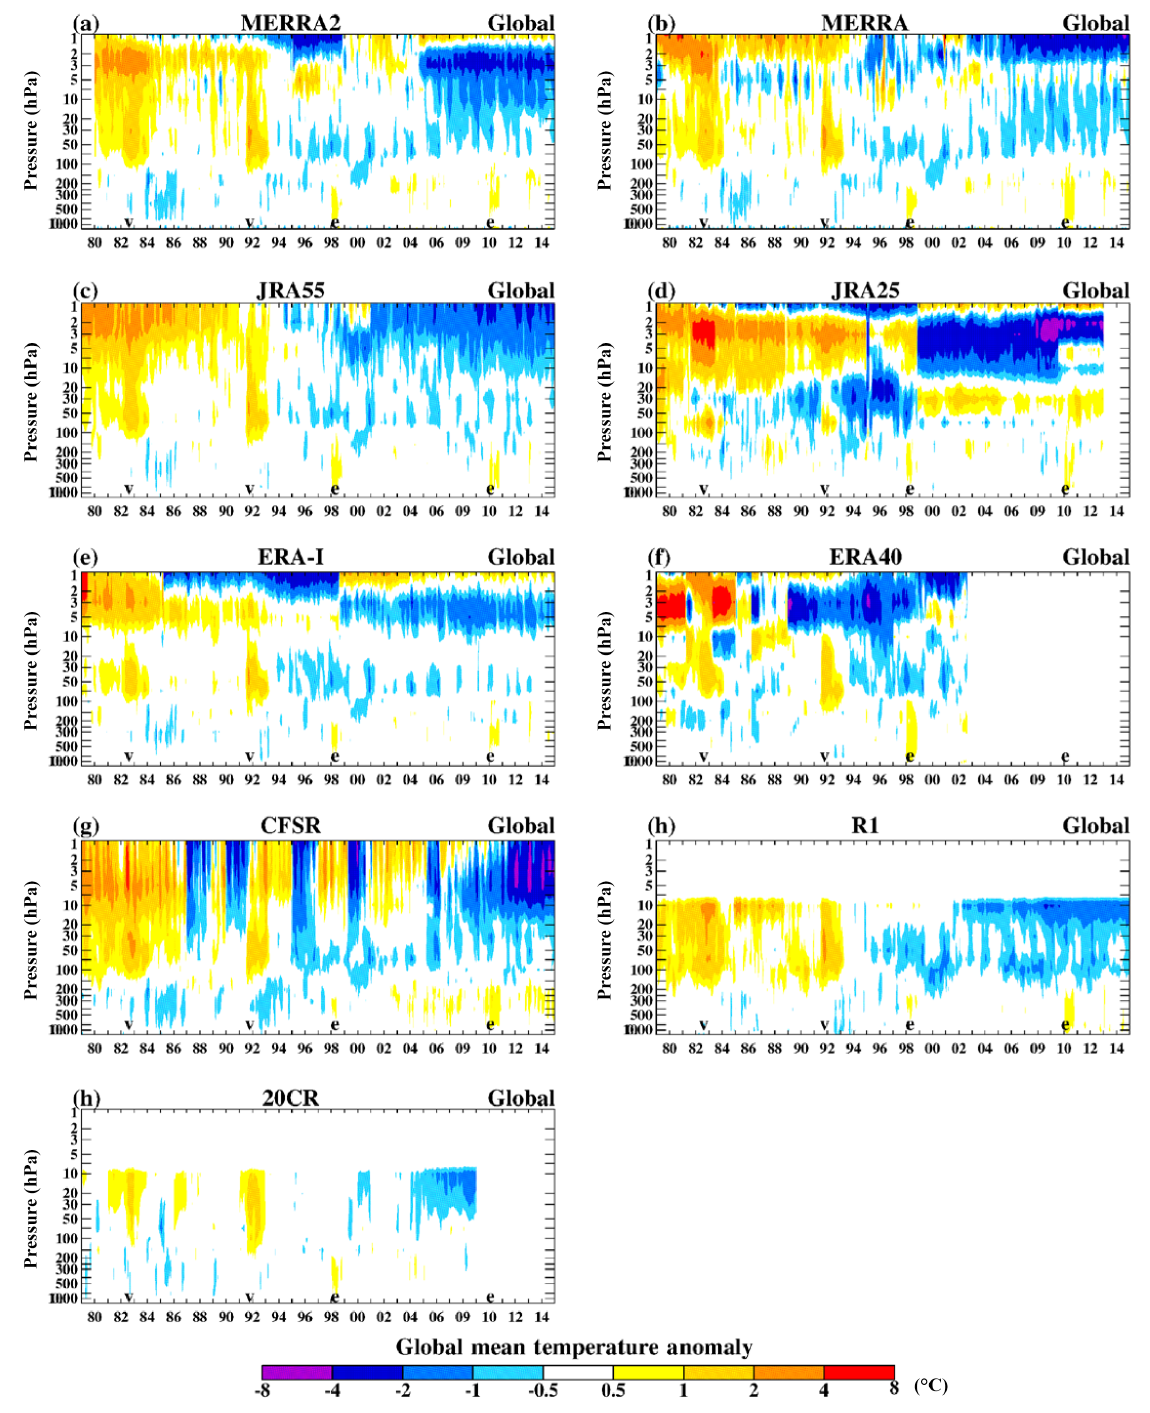
Figure 1. Pressure vs. time plots of the global mean temperature anomalies (K) of reanalyses. The anomalies are from the monthly clima- tology of each reanalysis. The reanalyses shown are (a) MERRA-2, (b) MERRA, (c) JRA-55, (d) JRA-25, (e) ERA-Interim, (f) ERA-40, (g) CFSR, (h) R1, and (i) 20CR. Note that R1 and 20CR do not provide analyses above 10hPa; “v” and “e” denote the occurrence of volcanos and El